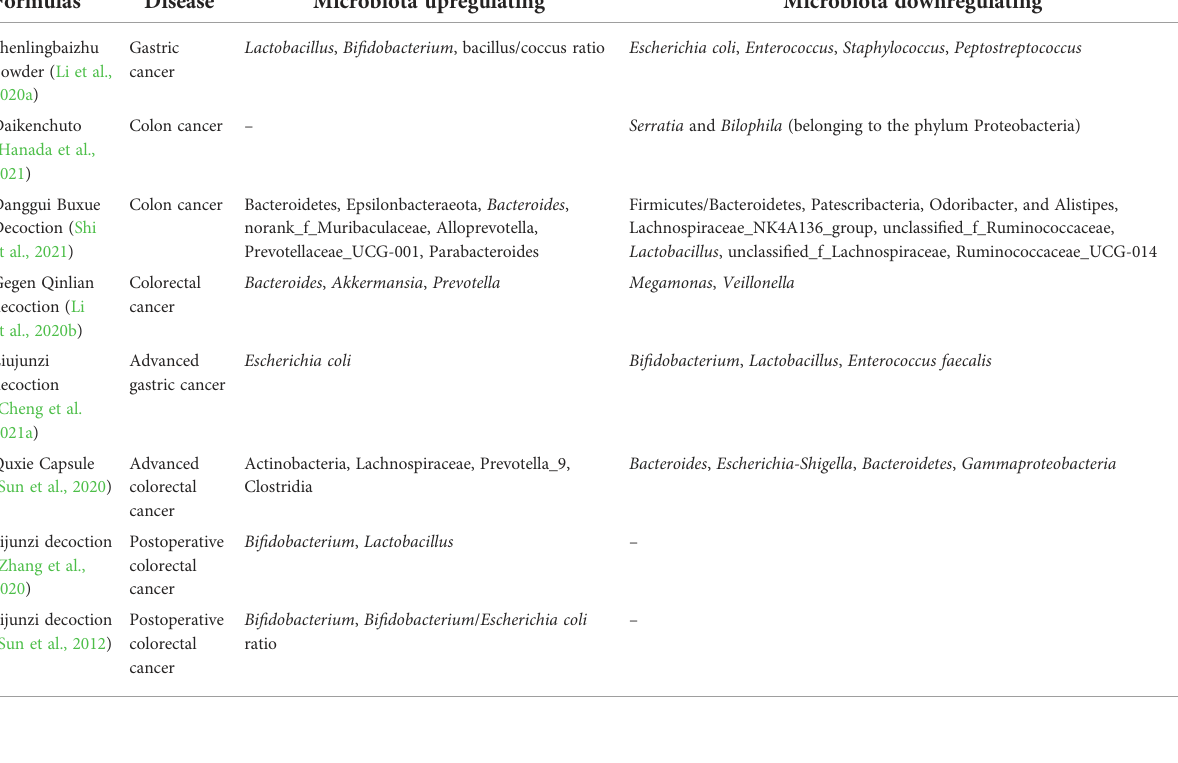
TABLE 2 Gut regulating function of herbal formulas.